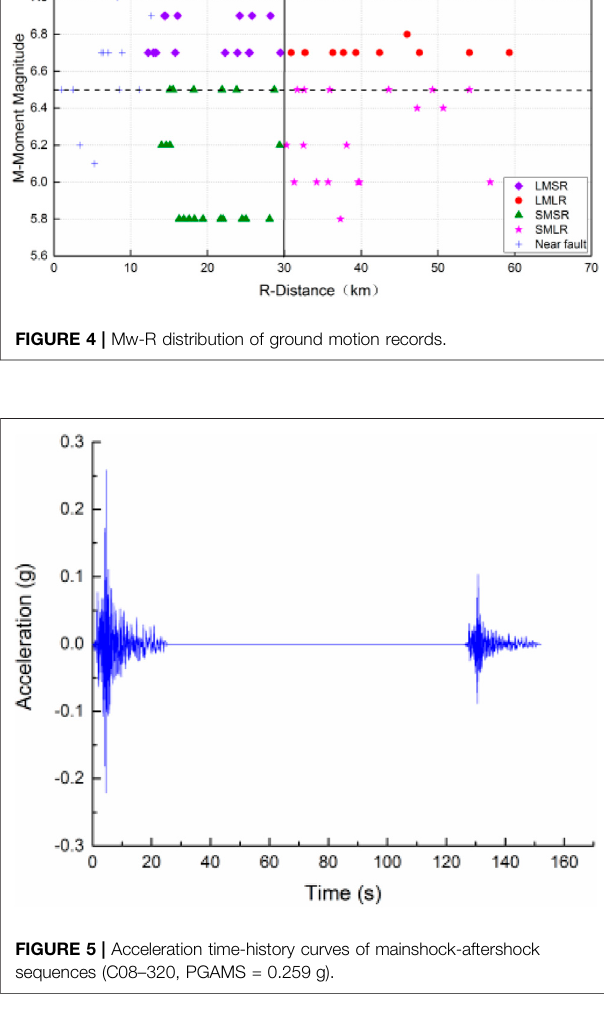
TABLE 1 | Comparison of maximum roof displacements of single-story masonry structural models under different mainshocks. No Earthquake